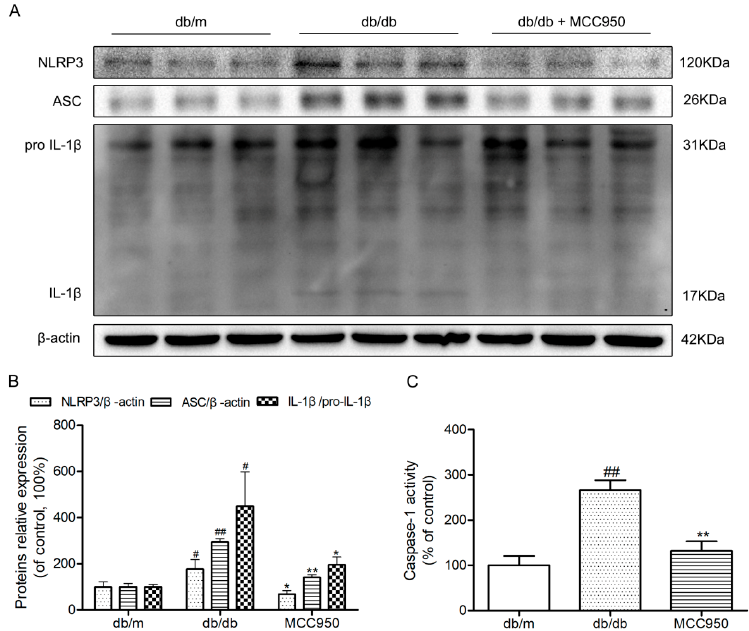
Figure 5. Effects of MCC950 on hippocampal NLRP3 inflammasome activation in db/db mice. ( A ) Western blot analysis of NLRP3 inflammasome-associated NLRP3, ASC, IL-1 β , and β -actin were performed in the hippocampus of each group; ( B ) The relative protein expression of NLRP3 to β -actin, ASC to β -actin, and IL-1 β to pro-IL-1 β are expressed in the bar graphs; ( C ) Caspase-1 activity in the hippocampus of each group, as reflected by the production of p -nitroaniline. All data are represented as mean ± SD ( n = 3). ## p < 0.01, # p < 0.05, compared with the db/m-group; ** p < 0.01, * p < 0.05, compared with the db/db-group.